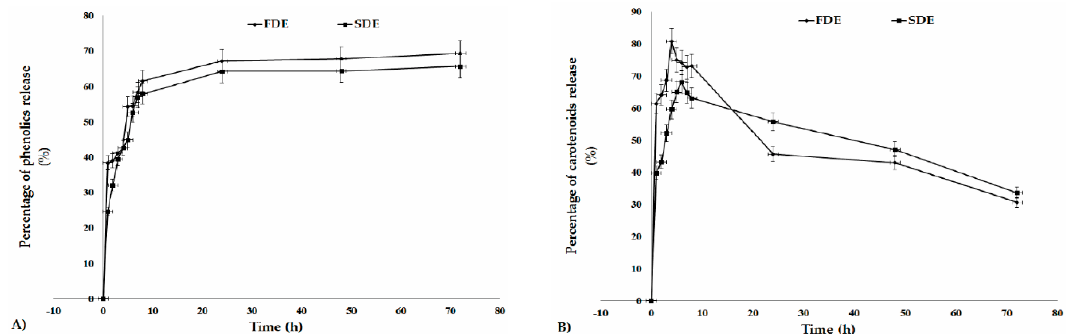
Figure 3. The release profile of phenolics ( A ) and β -carotene ( B ) from whey protein matrices under simulated conditions of the small intestine.